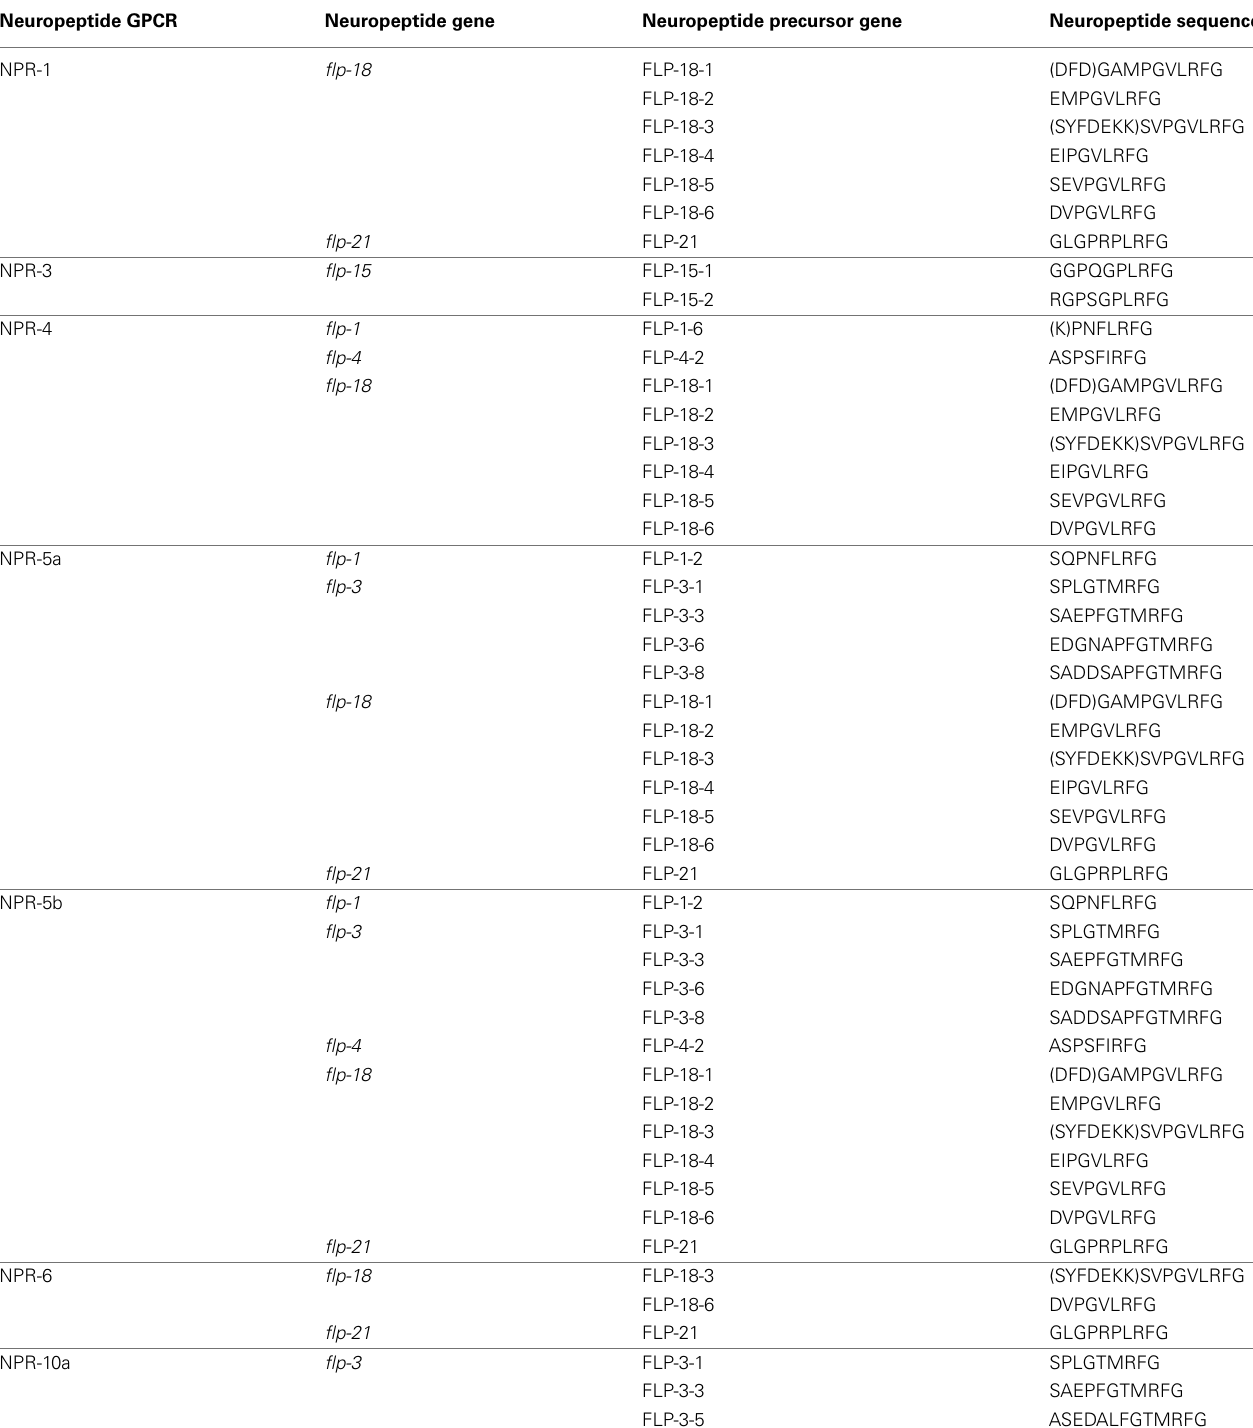
TableA1 | List of sequences of neuropeptide ligands produced by neuropeptide precursors and sorted according to the neuropeptide C. elegans GPCRs they